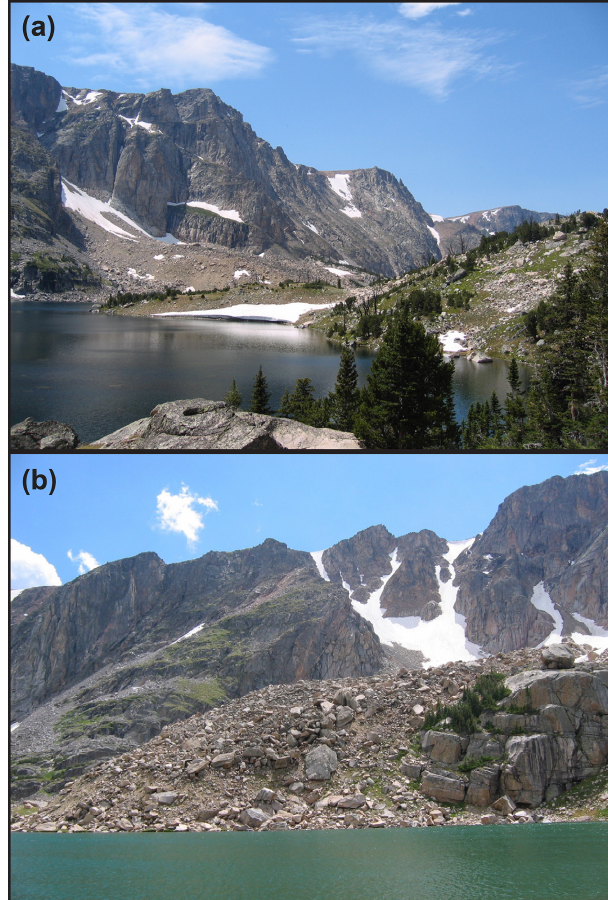
Figure 3. Beartooth moraines: (a) Emerald Lake moraine on the left, with the Little Glacier Lake moraines in the distance. (b) Toe and left-lateral aspect of the Little Glacier Lake moraine and bedrock